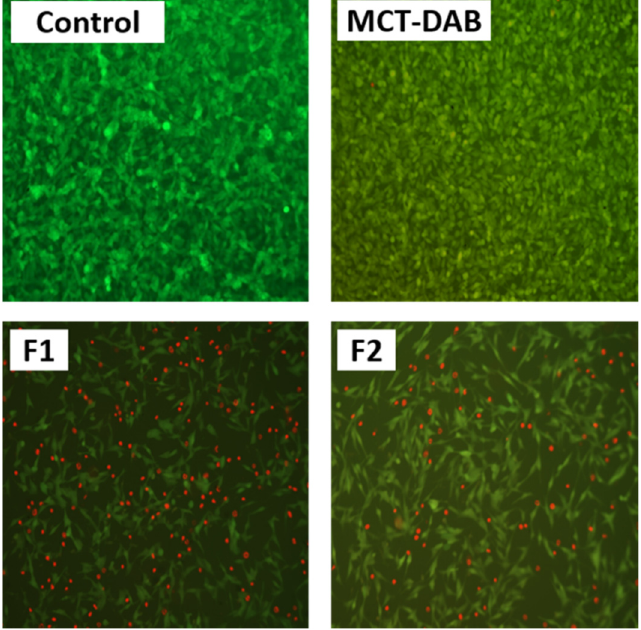
Figure 7. Live/dead cell staining of melanoma cell line. Cells were treated with 50 µg/mL for 24 h. Live cells appear green, while dead cells appear red.